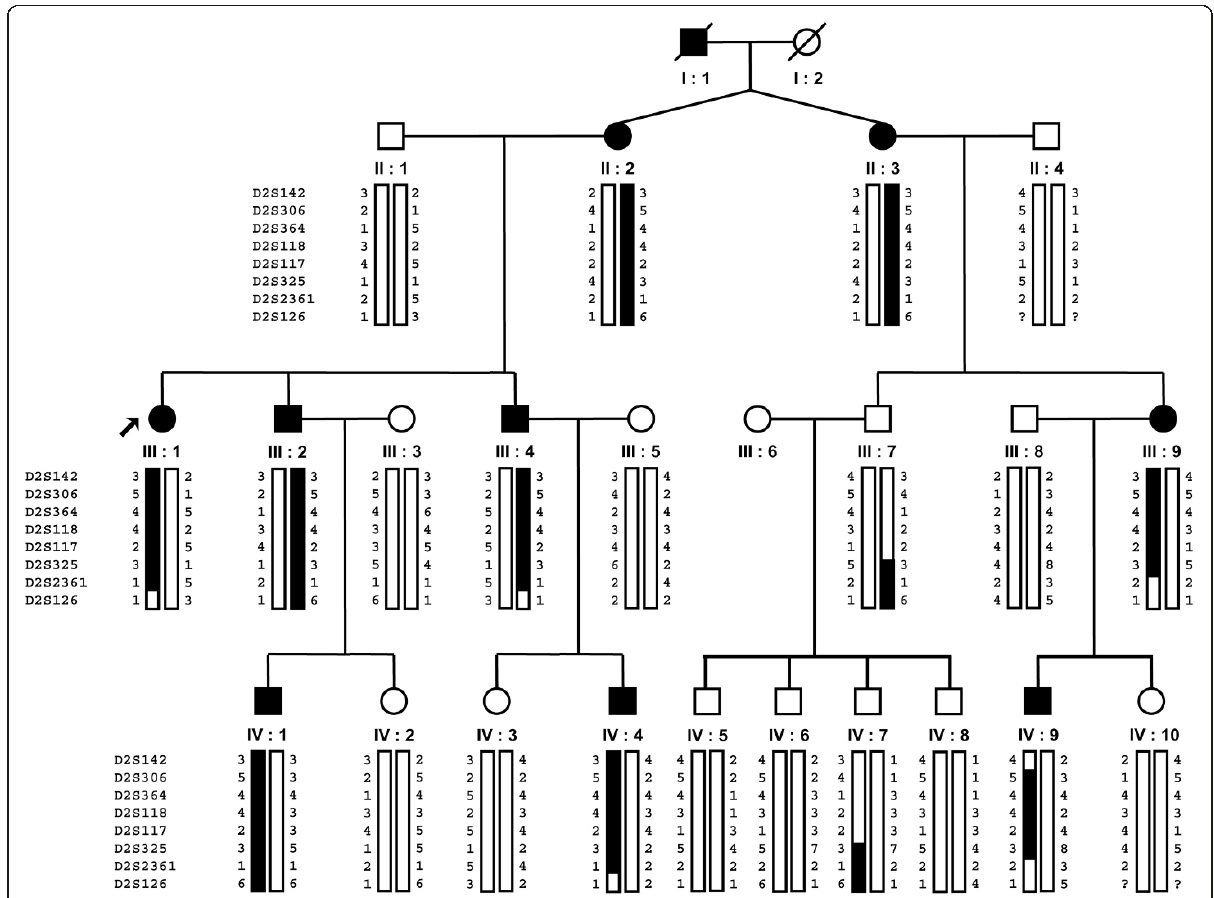
Figure 1 Pedigree of family RP470 with autosomal dominant inherited cone-rod dystrophy (adCRD) . Arrow indicates the index patient. Filled symbols represent members with adCRD and empty symbols represent unaffected patients. Haplotypes of microsatellite markers spanning the locus 2q24.2-2q33.1 are shown. Question marks indicate unknown alleles. Solid bars denote the haplotype that segregated with the disease